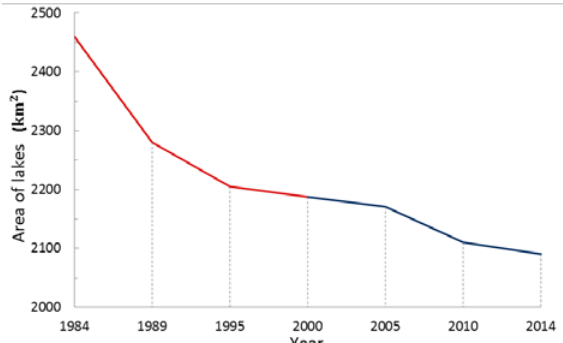
Figure 2. Changes of the total area of the Jianghan Lake Group from 1984 to